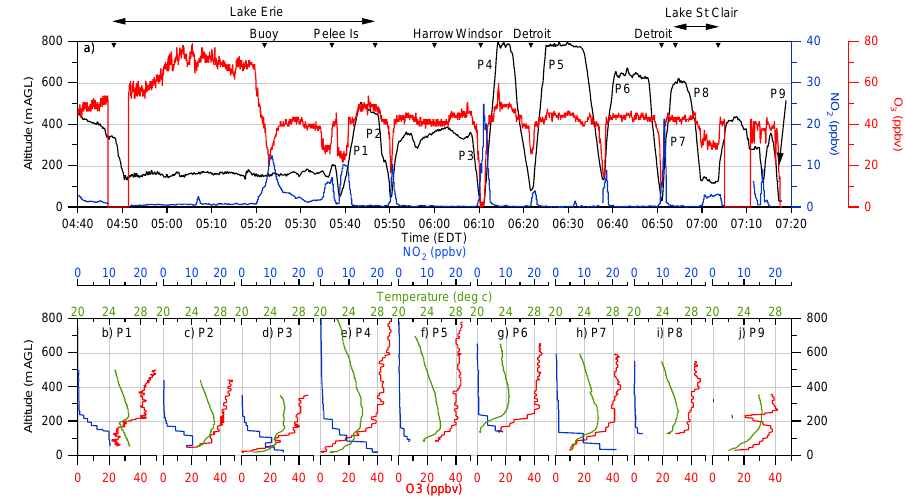
Fig. 8. (a) Twin Otter time series for 7 July showing O 3 , NO 2 , and elevation; (b–j) selected vertical profiles of O 3 , NO 2 , and temperature. Profile locations are indicated on Fig.